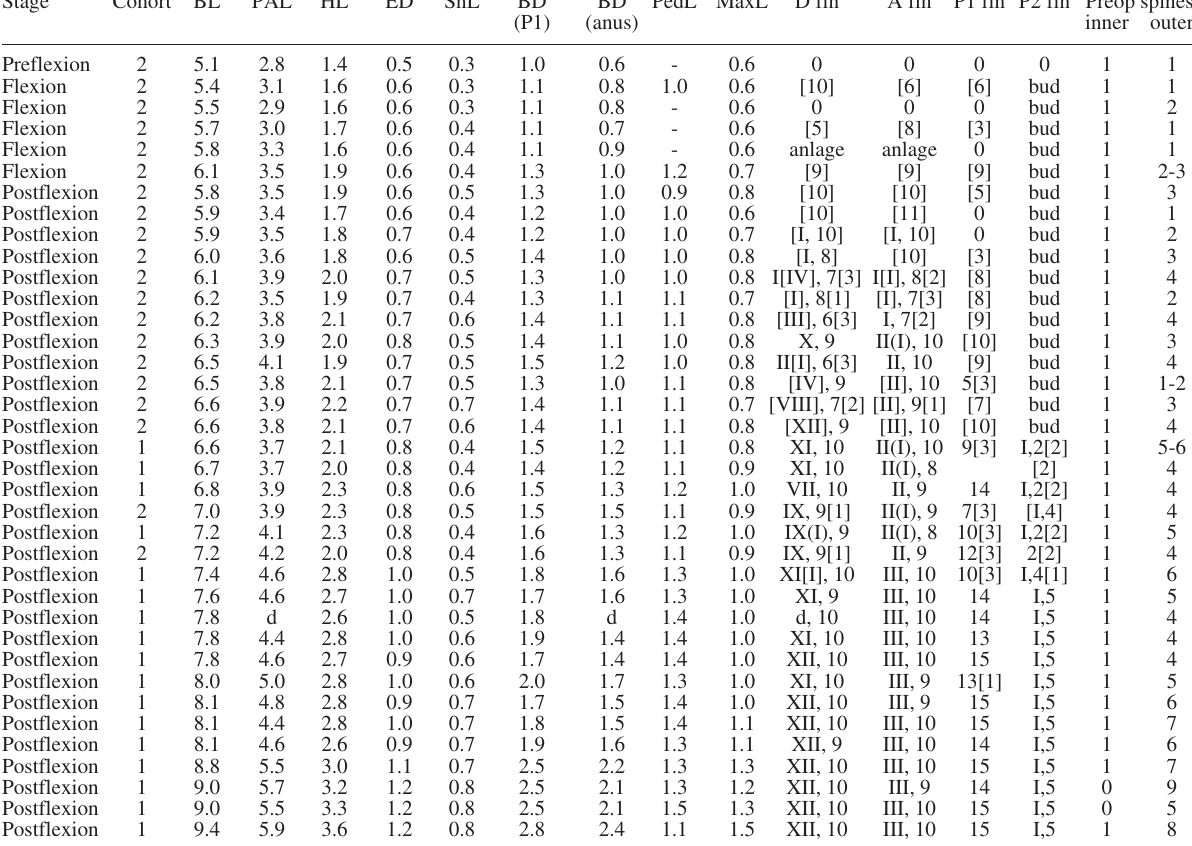
Table 1. – Morphometric and meristic values of reared larvae of Gramma loreto . Measurements (in mm) are post-shrinkage (see Methods). Abbreviations: BL, body length; PAL, pre-anal length; HL, head length; ED, eye diameter; SnL, snout length; BD (P1), body depth at Pectoral-fin base; BD (anus), body depth at anus; PedL, dorsal length of caudal peduncle; MaxL, length of maxilla. D, dorsal; A, anal; P1, pectoral; P2, pelvic. For fins [n] indicates numbers of incipient rays or spines, and (I) indicates a ray transforming into a spine. Preop, pre- opercular. Inner and outer refer to the borders of the pre-opercular bone: a range in values indicates bilateral asymmetry. In the body of the Table, d indicates damaged. Stage Cohort